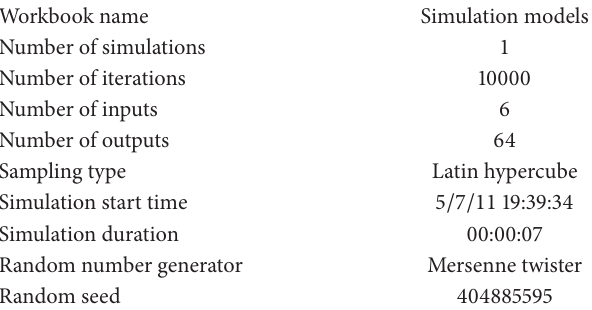
Table 6: The simulation